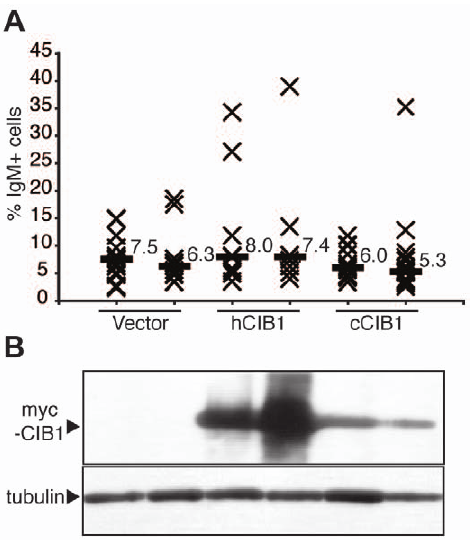
Figure 2. CIB1 over-expression in DT40. A . An IGC fluctuation analysis showing the percentage of surface Ig-positive cells in subclone cultures over-expressing human (h) or chicken (c) CIB1. Each X represents data from an individual subclone and the labeled horizontal bars report the medians for each data set. B . CIB1 over-expression confirmed by immunoblotting. Loading was controlled by stripping and re-probing the blot with an a -tubulin antibody.